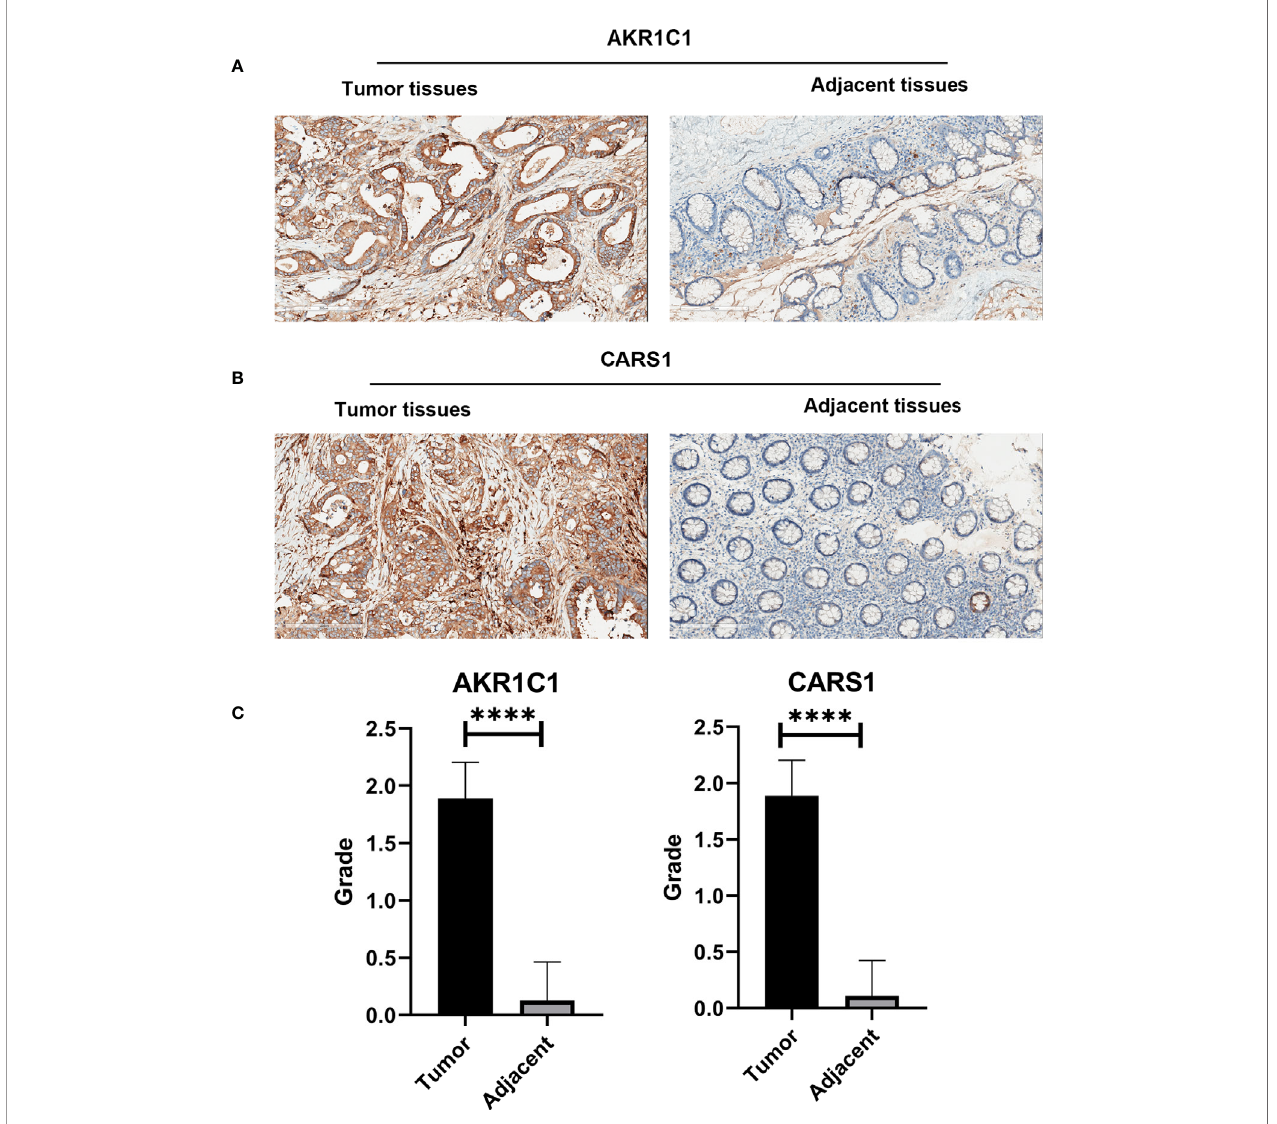
FIGURE 7 | The immunohistochemistry images from wet lab. (A) The representative images of AKR1C1 in the tumor tissues and adjacent tissues. (B) The representative images of CARS1 in the tumor tissues and adjacent tissues. (C) The statistical results of expression of AKR1C1 and CARS1 in the tumor tissues and adjacent tissues; ****P